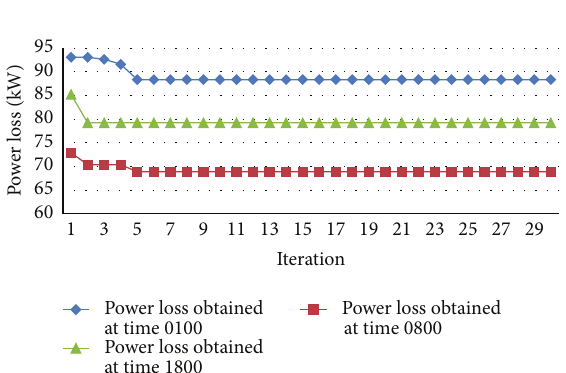
Figure 8: Convergence performance of GSA with proposed method at selected time of a